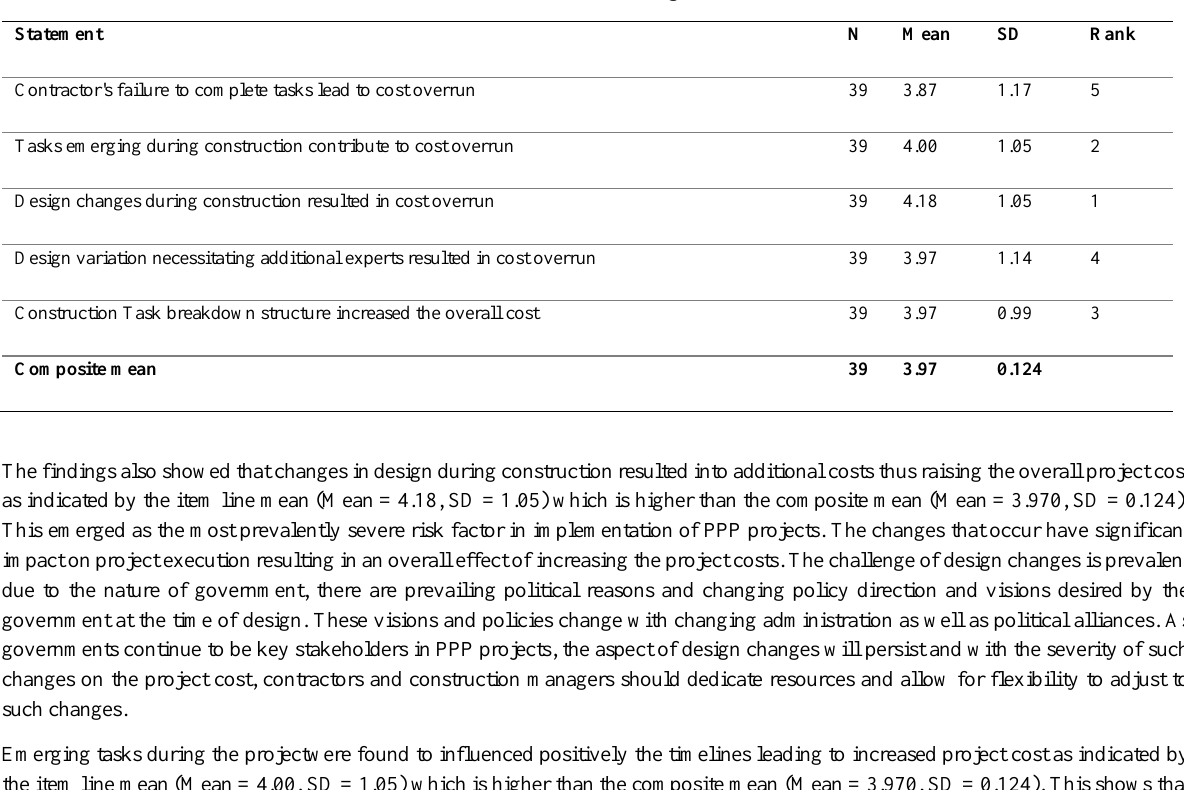
Table 1: Risk Factors Contributing to Cost